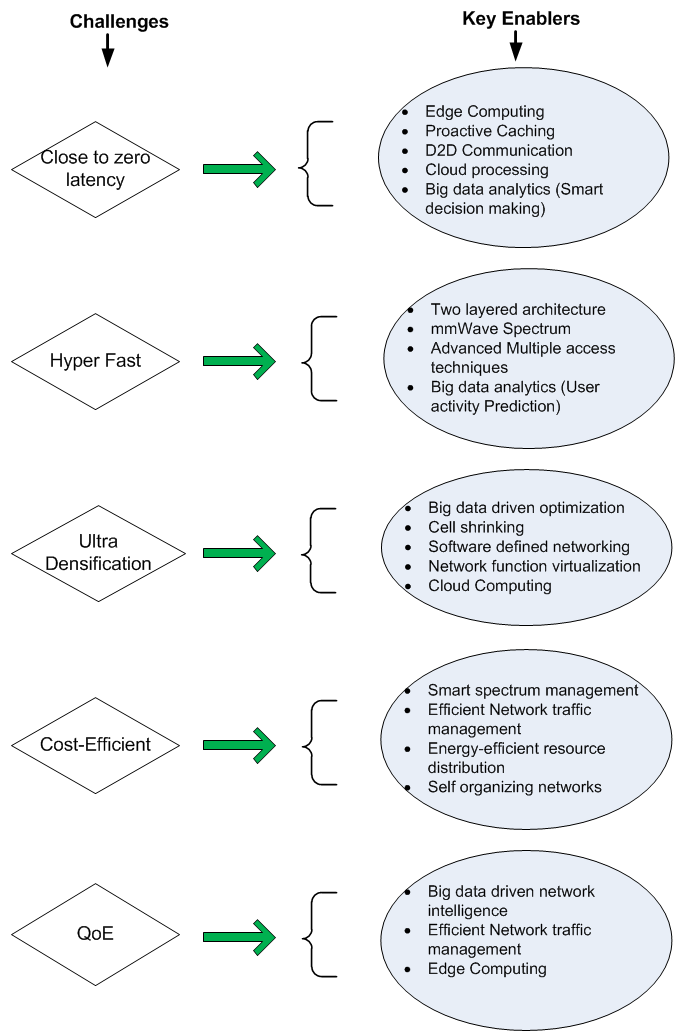
Figure 4. Challenges and key enablers for next-generation networks (inspired from